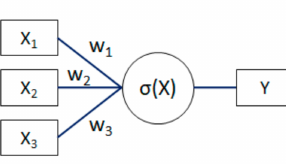
Figure 4. The basic calculation principle of one neuron. X 1 , X 2 , and X 3 are the input of the neuron; W 1 , W 2 , and W 3 are the weight of each input X; the activation function of the neuron is σ (X); Y is the output of the